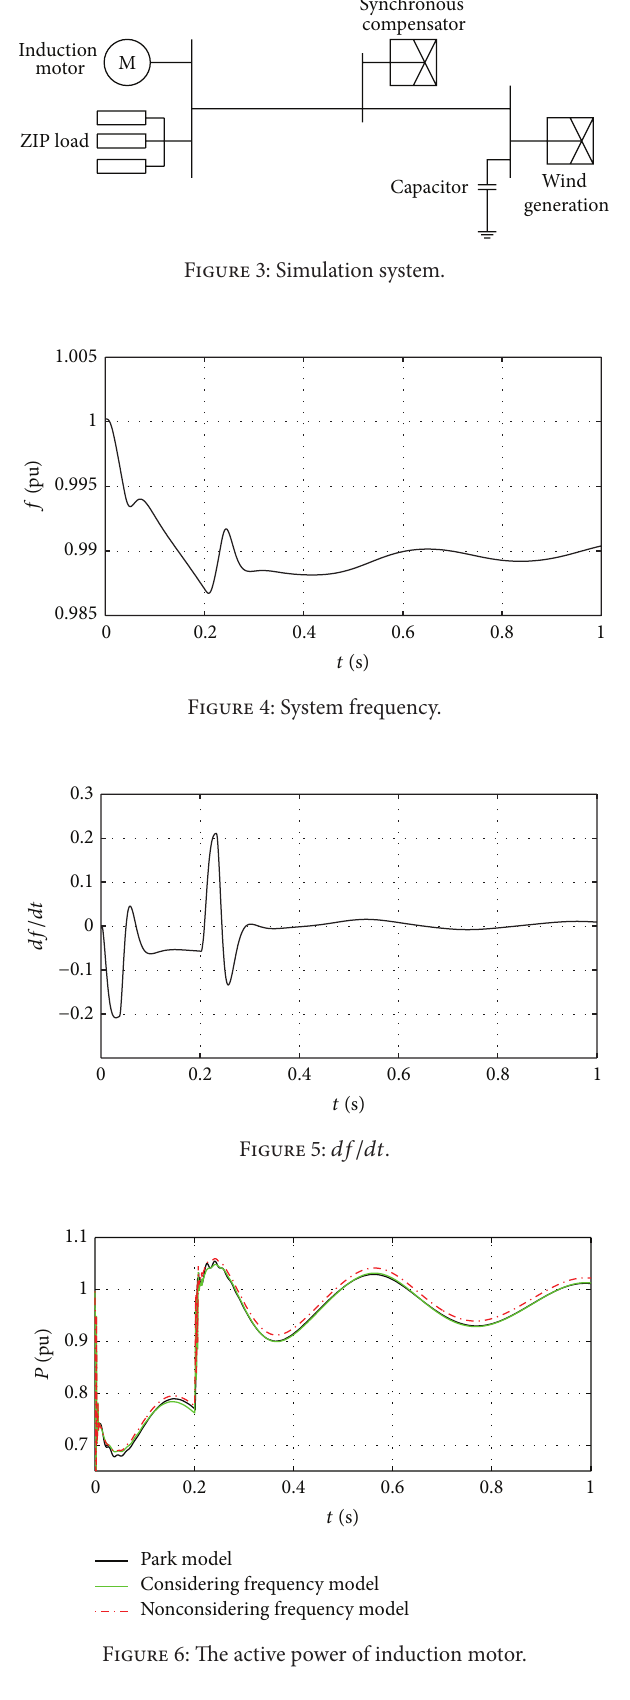
Table 3: Error analysis of different models.